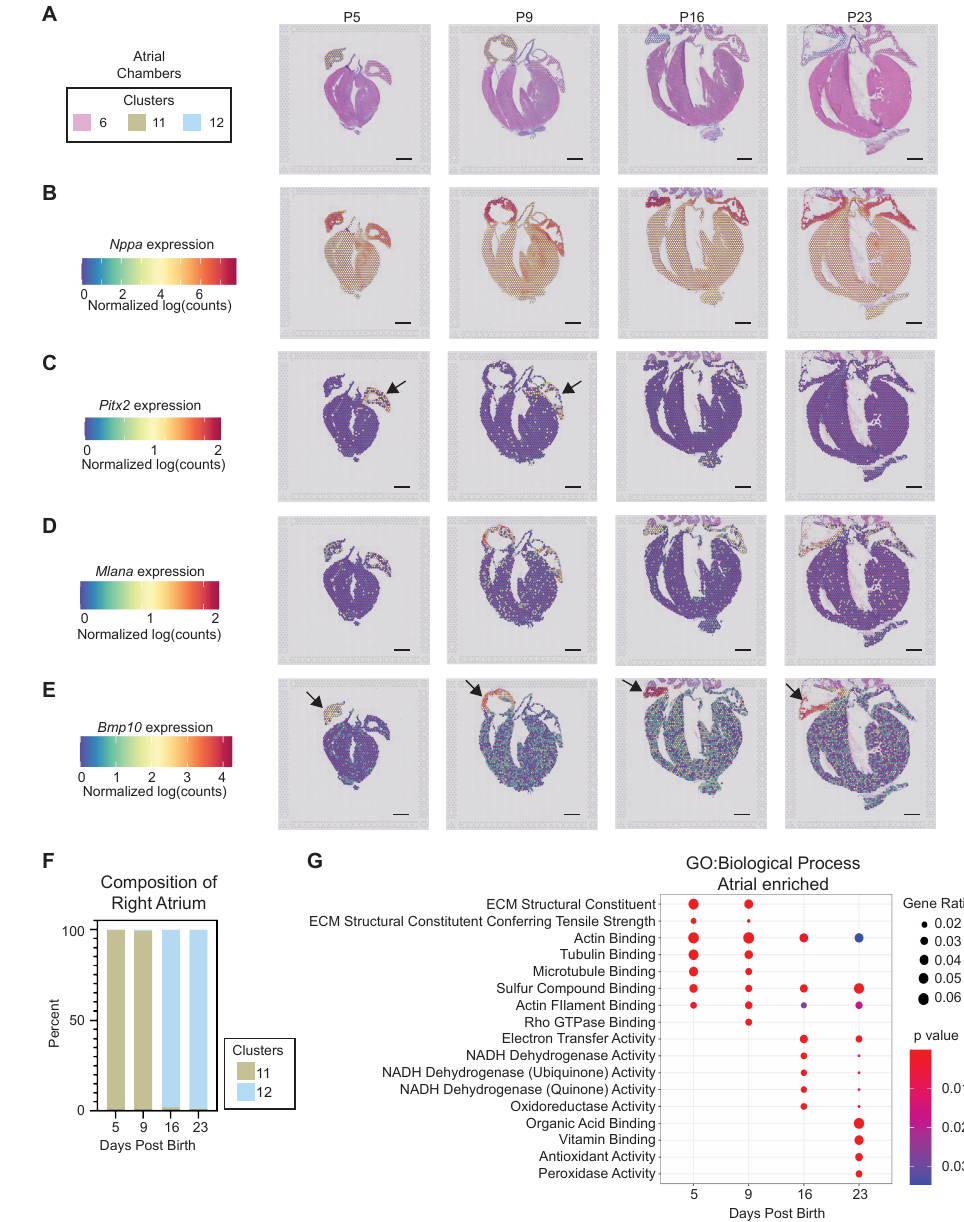
Figure 4. Spatial transcriptomics defines postnatal program of atrial chamber maturation. ( A )